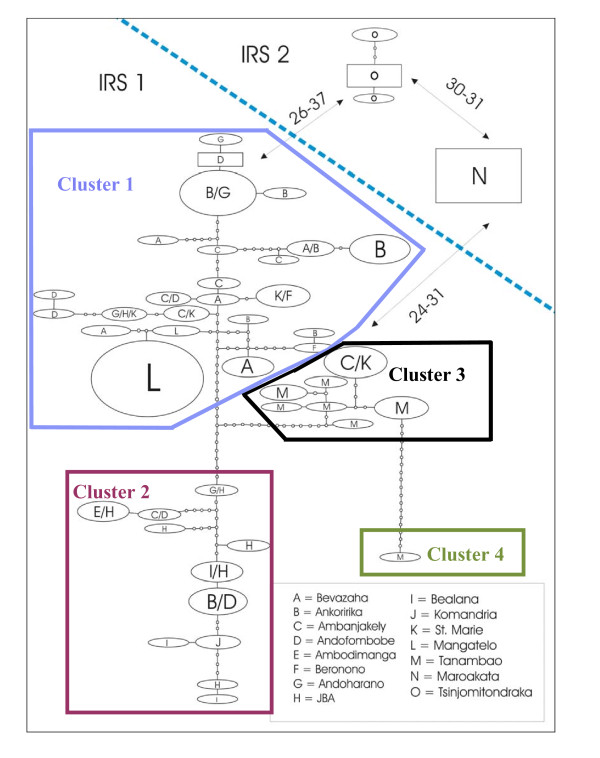
Haplotype networks in IRS1 and IRS2. The size of ovals and squares is proportional to the number of individuals that share a haplotype. The haplotypes with the highest outgroup probability are displayed as a square, the other haplotypes are displayed as ovals [54]. Each node represents a mutation step between haplotypes. The numbers of mutation steps between the networks of the IRS2 and the network of the IRS1 are provided (see arrows). The haplotypes of IRS1 belong to four different clusters, separated by at least ten mutation steps.